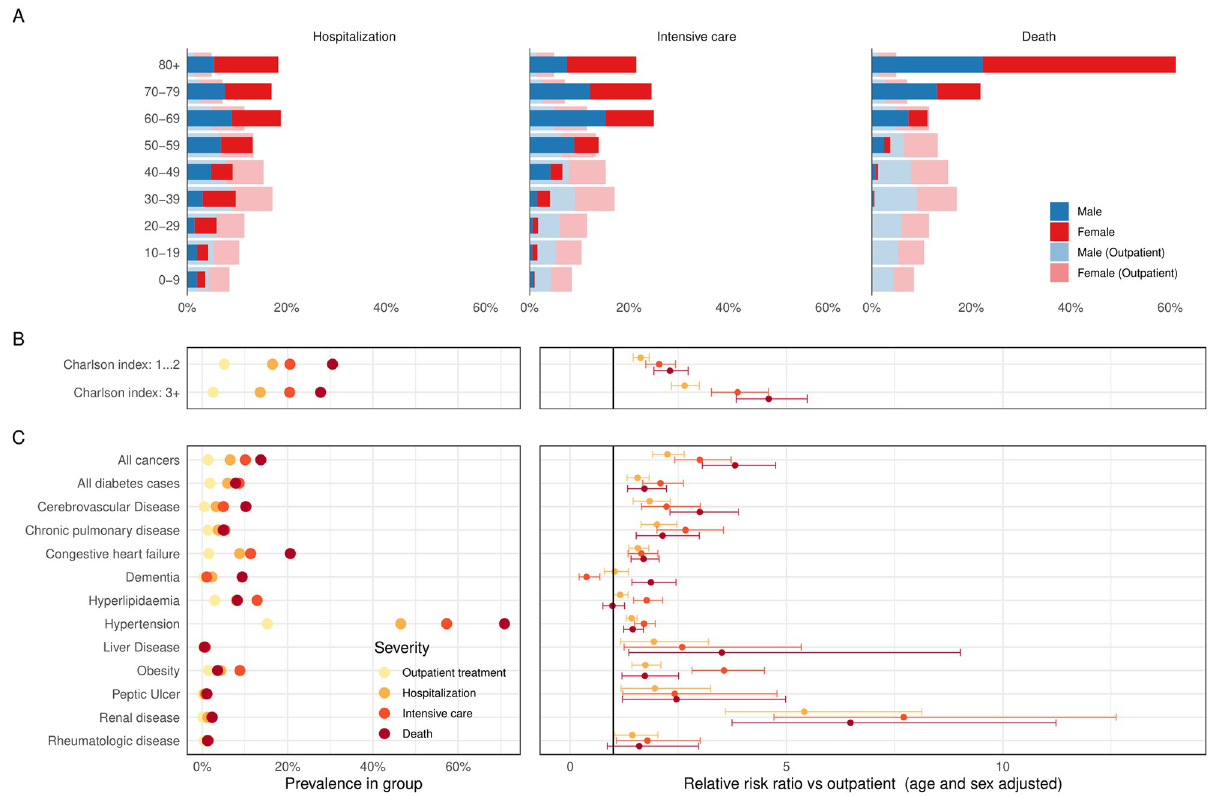
Fig 2. Factors associated with COVID-19 severity. (A) Proportion of patients with severe COVID-19 disease (hospitalized, admitted to intensive care unit or died) stratified by age and sex compared with those who required outpatient treatment only. (B) Forest plot showing the association between CCI index and risk of COVID-19 associated hospitalization, intensive care treatment and death, adjusted for age and sex. (C) Forest plot showing the association between comorbid diseases and risk of COVID-19 associated hospitalization, intensive care treatment and death, adjusted for age and